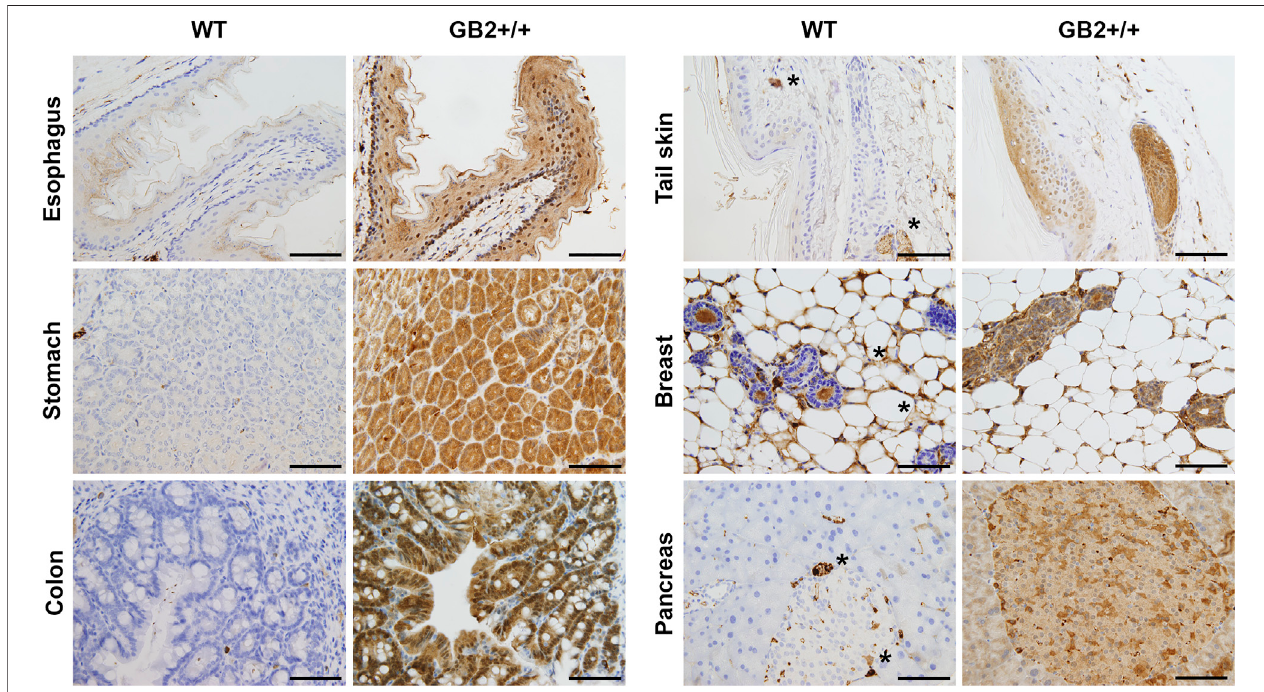
FIGURE 3 | Immunohistochemical expression of GSDMB2-HA in different tissues of the R26-GB2 mouse model. Representative images of tissues from homozygous (GB2+/+) and control (WT) mouse littermates. * Unspeci fi c staining. Scale bar, 100 µm.